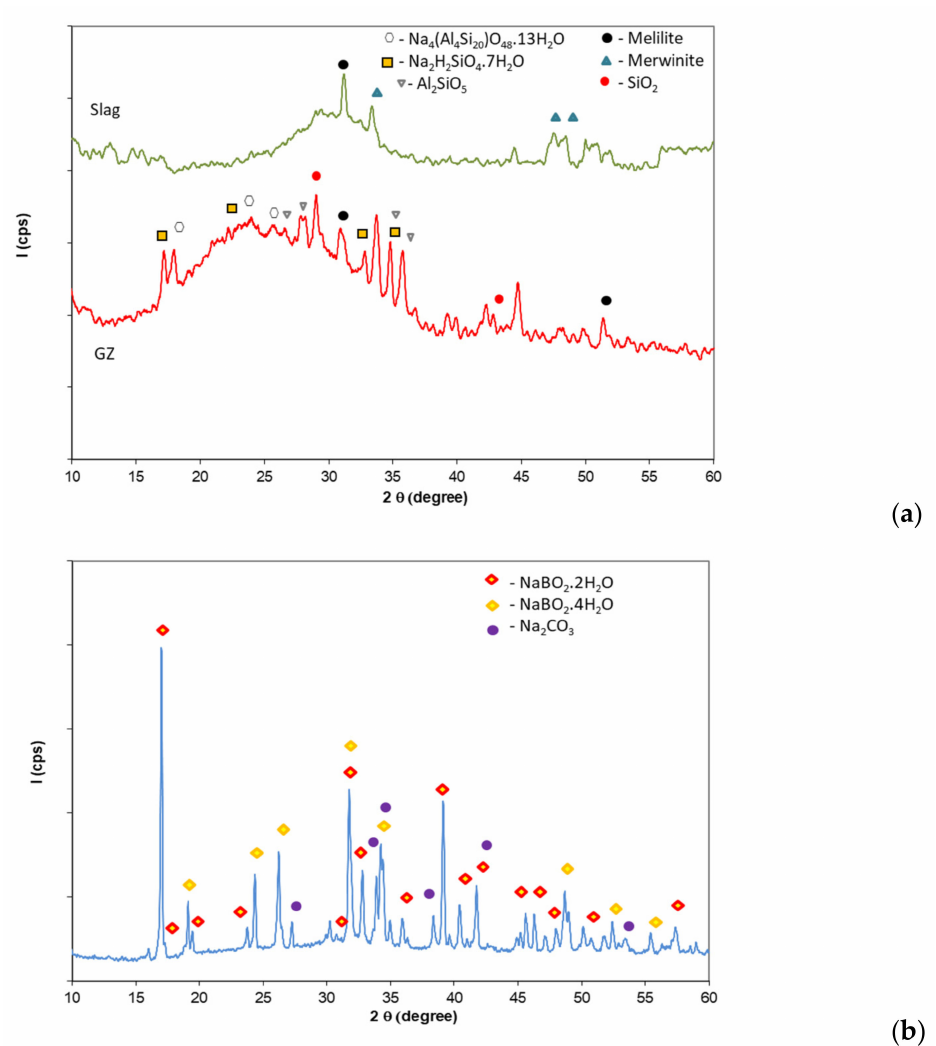
Figure 2. XRD patterns of: ( a ) slag and alkali-activated mixture of waste glass and slag (GZ); ( b ) waste glass activated with a mixture of NaOH and borax